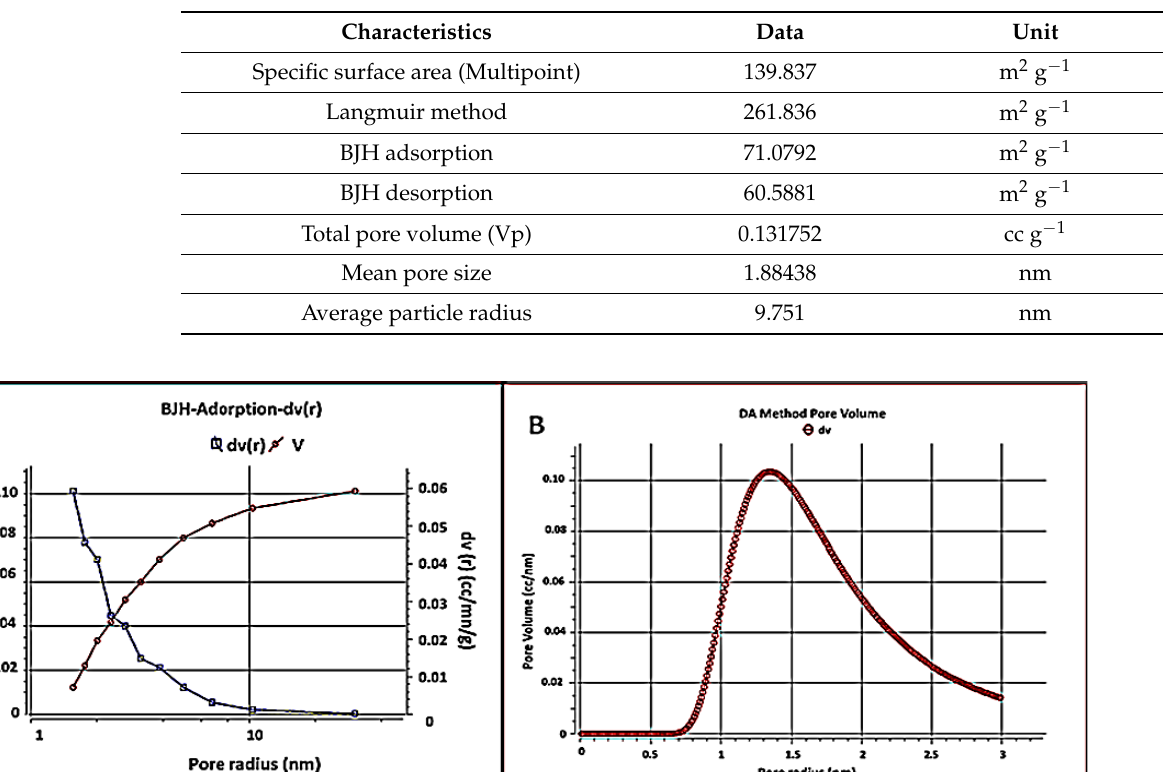
Table 3. BET analysis of A. platensis nanoparticles.